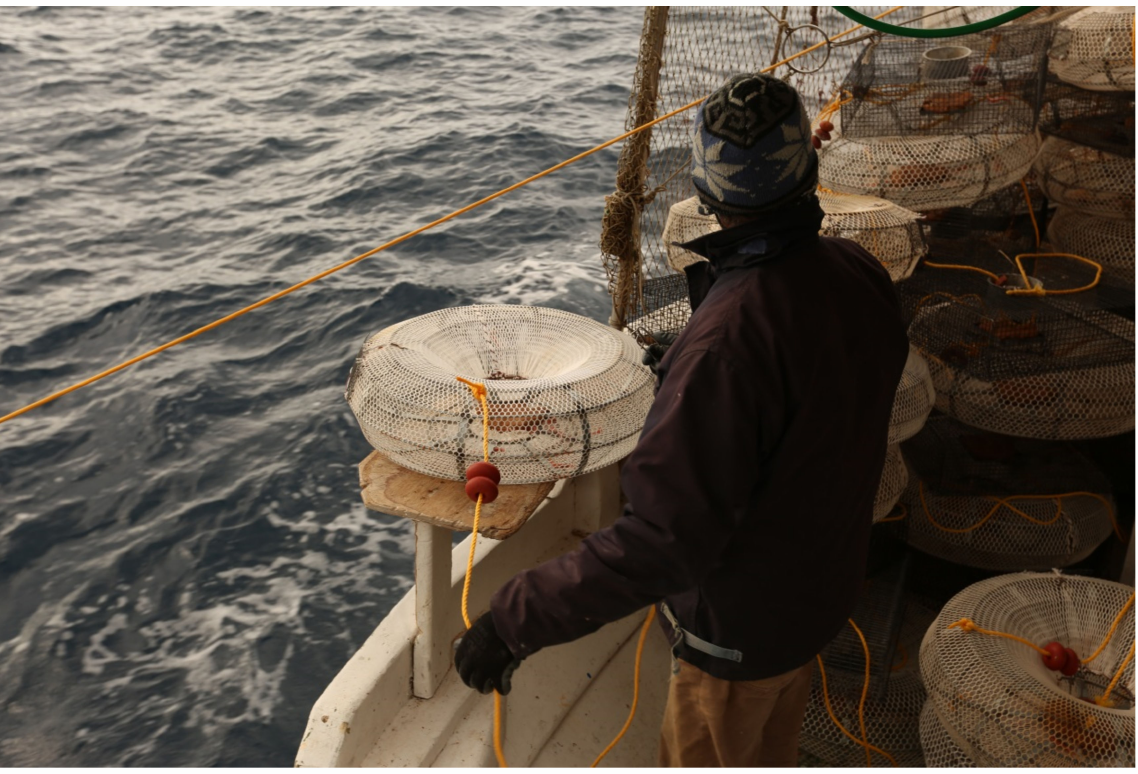
Figure 2. Commercial shrimp traps covered with polyamide-based nets of a mesh size of 12 mm (knot to knot) with an upper trap opening of 13